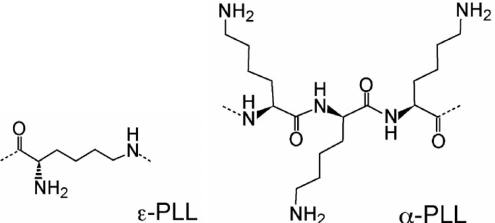
Figure 2. Structure of polylysine polymers employed to prepare PLL-microgel mixtures. ε -PLL ( left ), a homopolymer consisting of the l-lysine residues linked by the peptide bonds between the ε -amino and the α -carboxyl groups. α -PLL ( right ), a homopolymer of l-lysine, whose structure is represented by three residues linked by peptide bonds between the α -amino and α -carboxyl